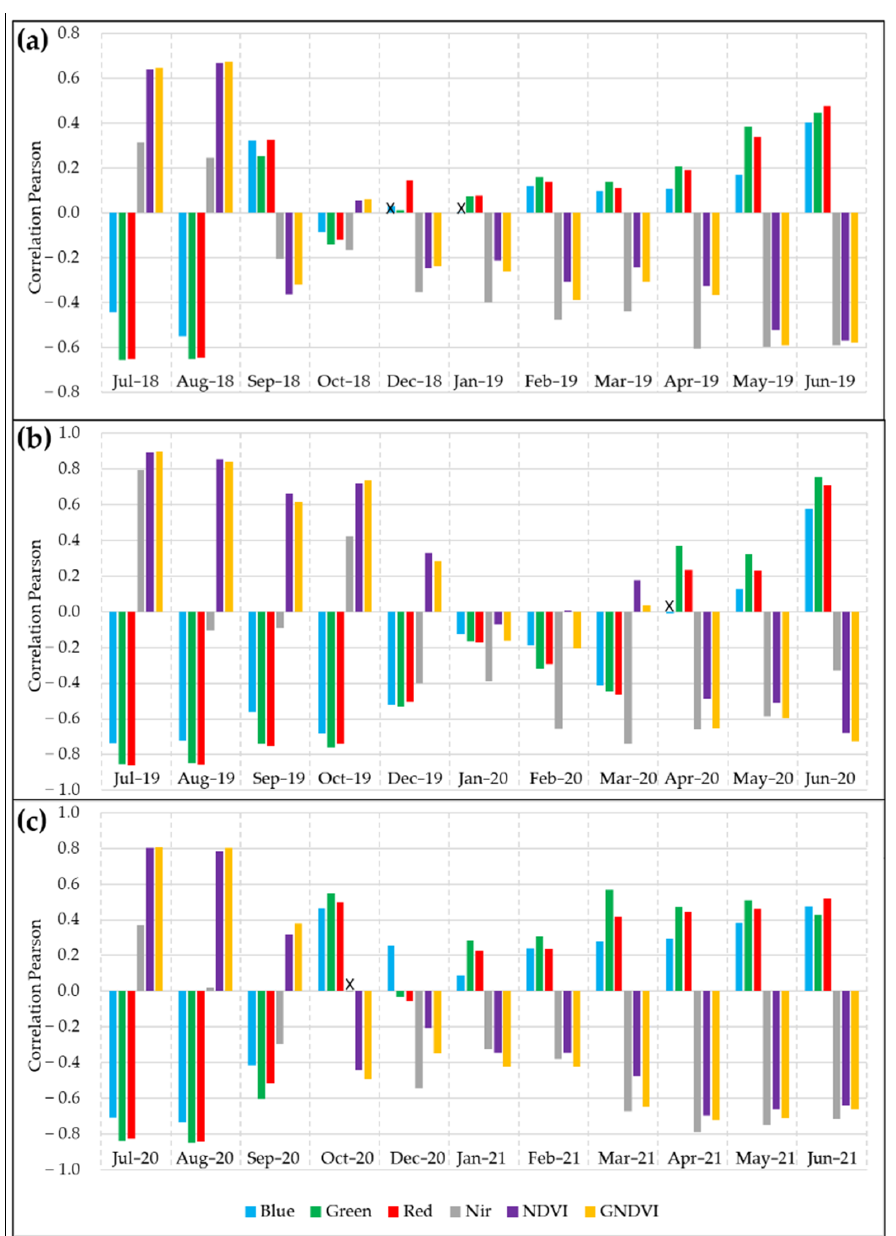
Figure 3. Pearson correlation between spectral bands/vegetative indices and coffee yield at a significance level of 5%. Cross-marks (X) mean that the variables were not significant. Nir: Near infrared, NDVI: Normalized Difference Vegetation Index, GNDVI: Green Normalized Difference Vegetation Index. ( a ) 2019 harvest; ( b ) 2020 harvest; ( c ) 2021 harvest.